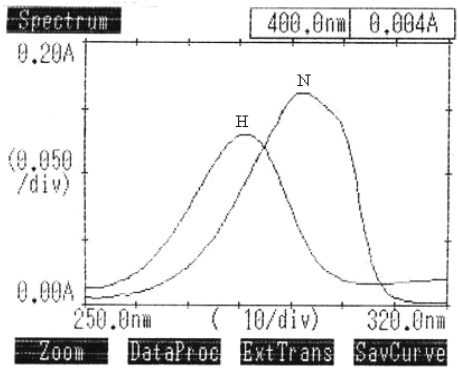
Figure 1. Overlain spectra of the tablet sample (NEB-H &